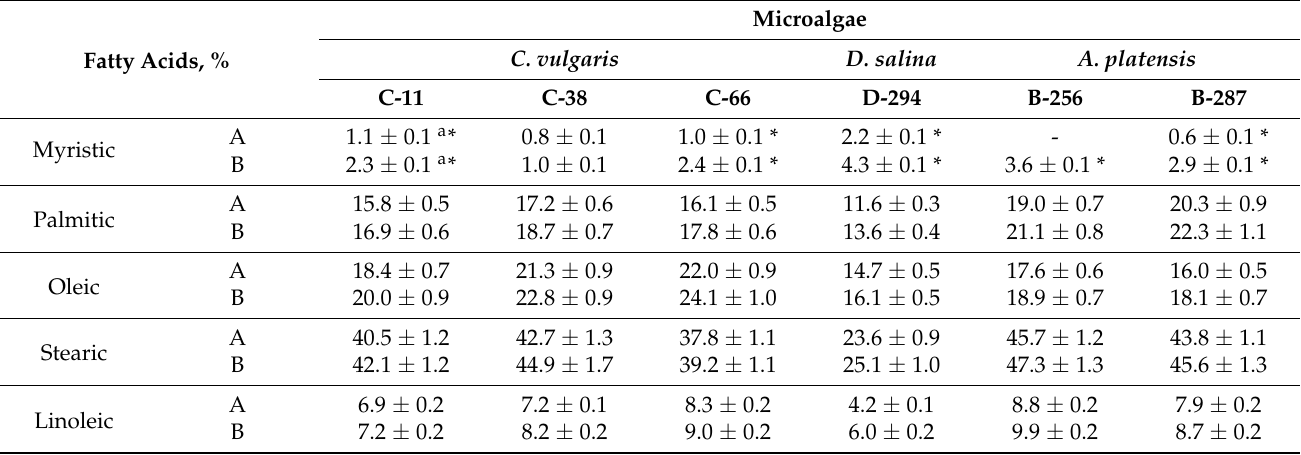
Table 8. Fatty acid composition of the lipid fraction of 100 g microalgae without (A) and with (B) the addition of